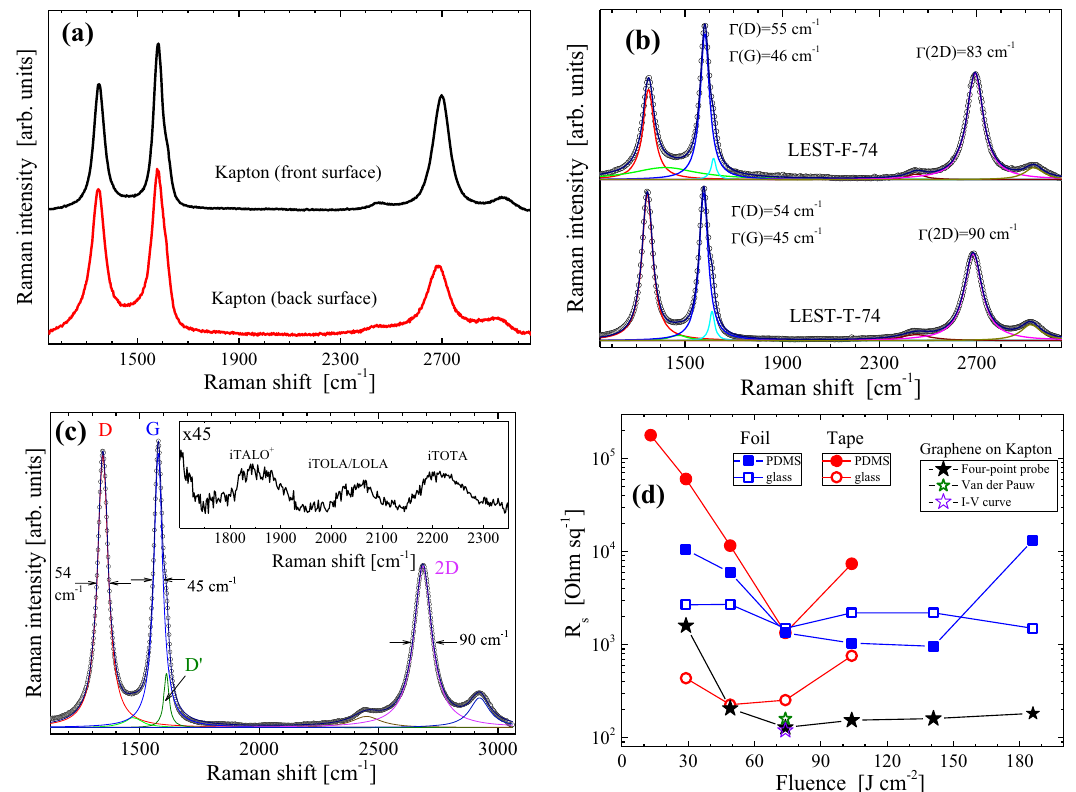
Fig. 4 Raman data and electrical properties. Raman spectra of a graphene fl akes grown on front and back side of Kapton foil in the course of a single irradiation step, and b graphene fl akes grown by LEST for the foil and tape precursors ( fl uence: 74 J cm − 2 ). c Lorentzian line fi tting of a Raman spectrum; the inset shows in magni fi cation the spectral area of the turbostratic peaks. d Sheet resistance of graphene and graphene/ SiO x transferred onto glass and PDMS substrates. For comparison R s for graphene grown on Kapton foil is also